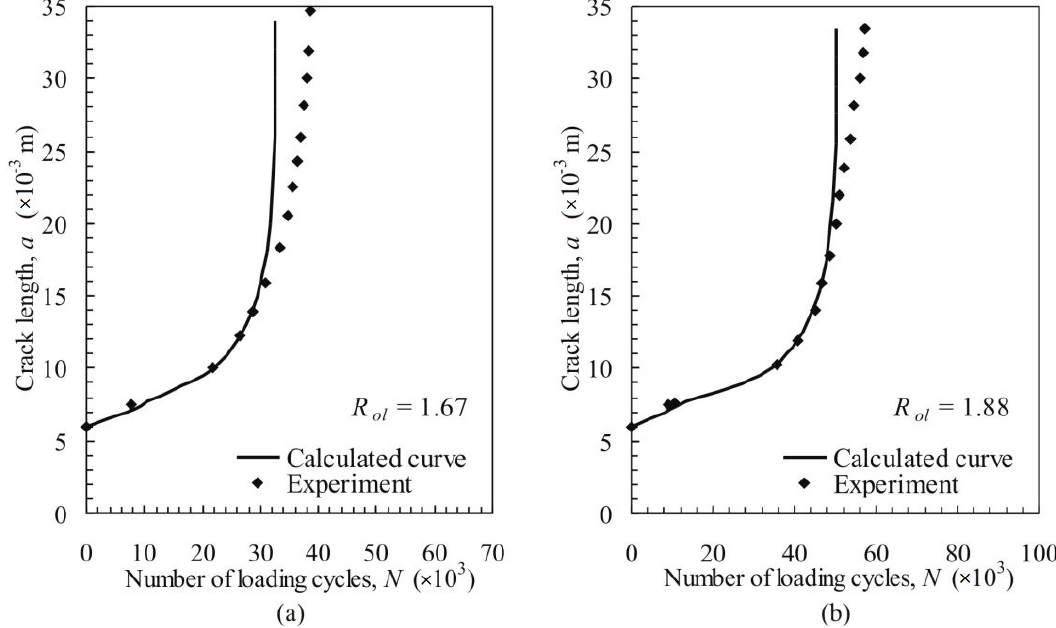
Figure 3. Fatigue resistance analysis: ( a ) a versus N , R ol = 1.67 and ( b ) a versus N , R ol = 1.88, calculated curves from the present work, experiments reported by Kumar [32].